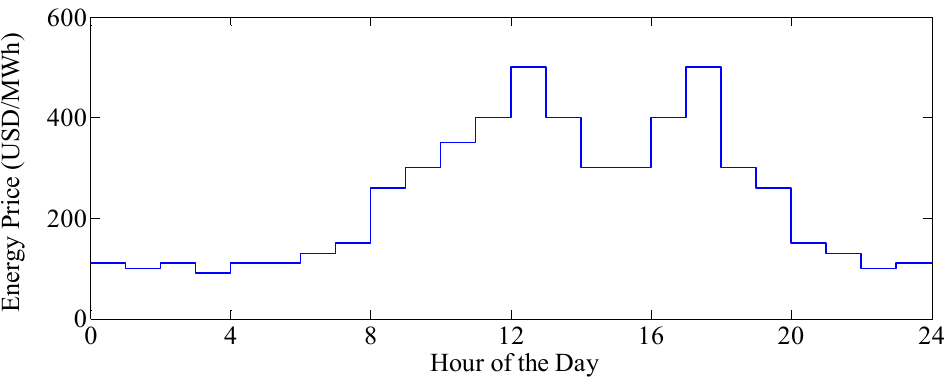
Figure 3. Hourly energy